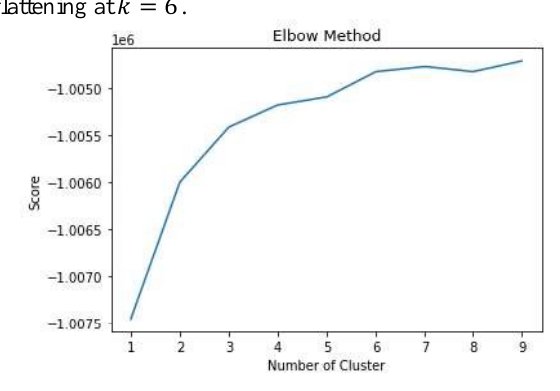
Figure 8. Optimal number of the cluster for K-means generated by Elbow method